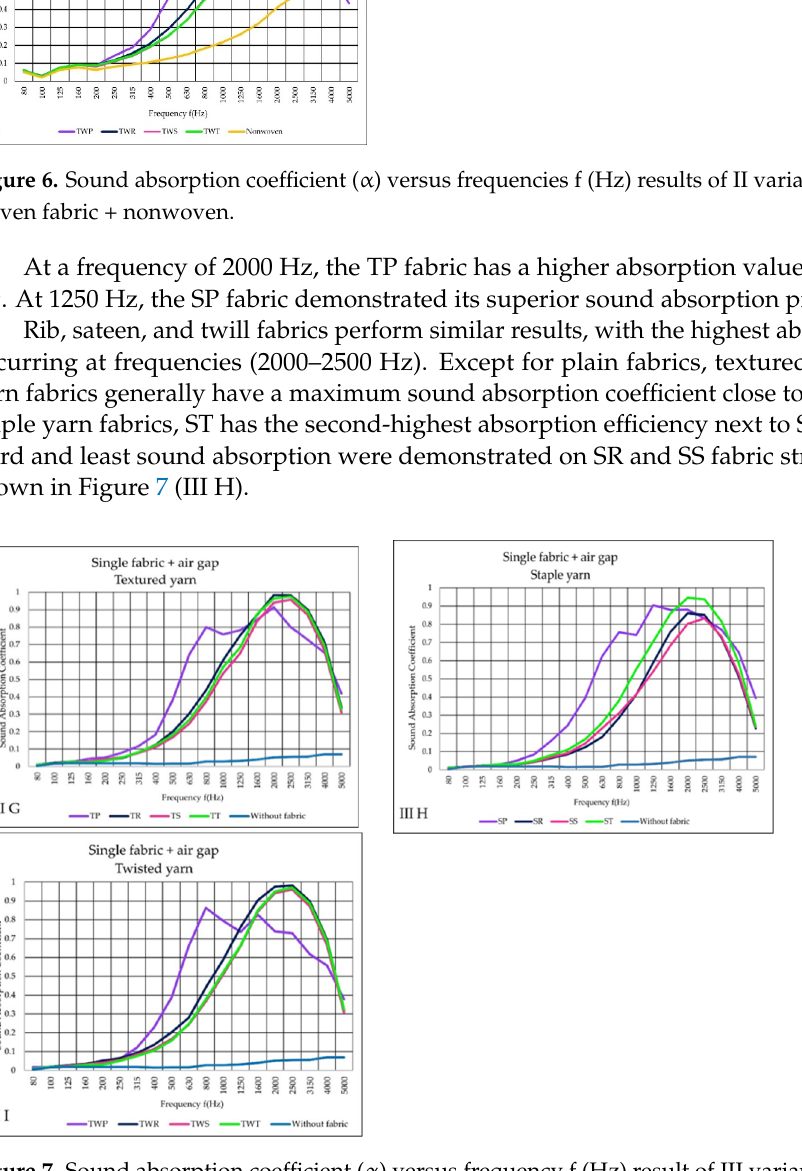
Figure 7. Sound absorption coefficient ( α ) versus frequency f (Hz) result of III variant, ( G – I ) single woven fabric + air gap.